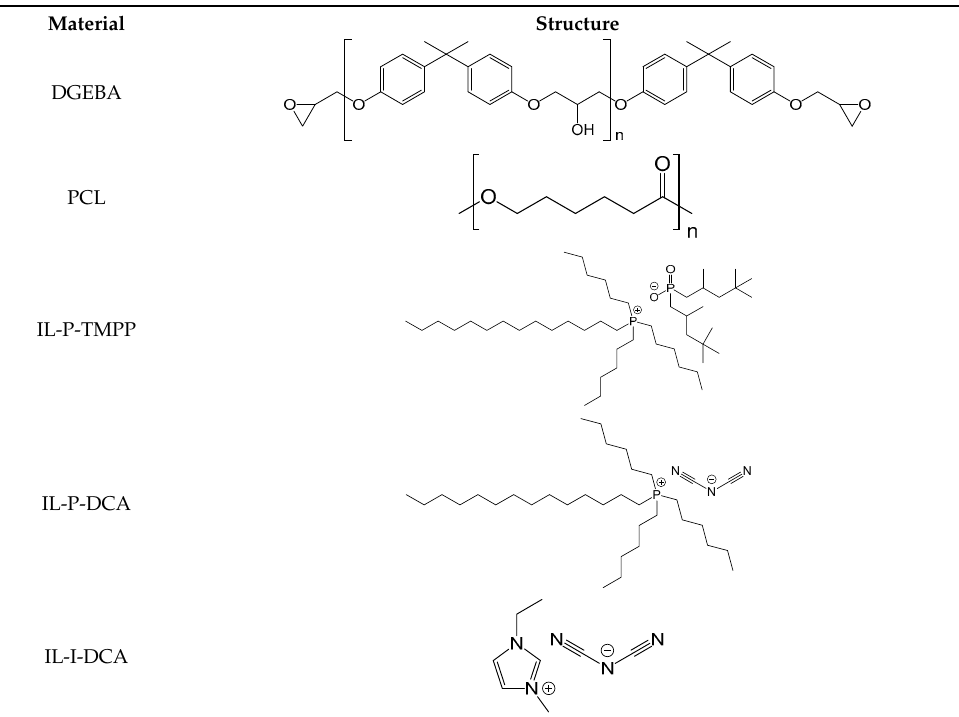
Table 2. Chemical structure of the materials studied.